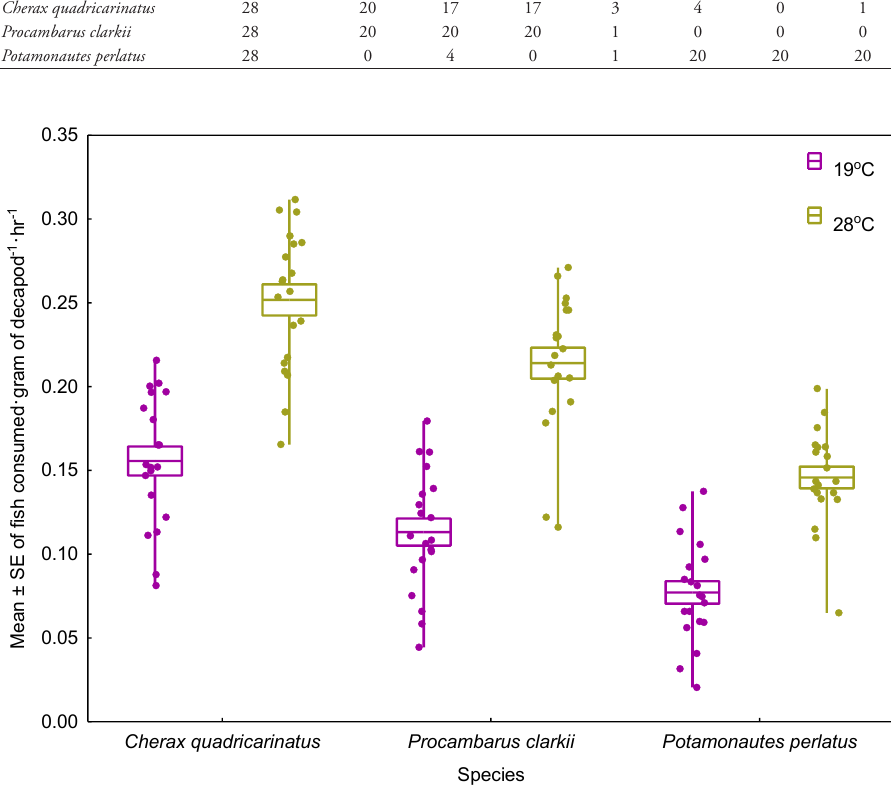
Figure 2. Mean consumption of fish ( Oreochromis mossambicus ) per hour per gram of Cherax quadricari- natus , Procambarus clarkii and Potamonautes perlatus at 19 °C and 28 °C. Points indicate raw data values, boxplots indicate ± Standard Error and solid line across the box represents the mean.